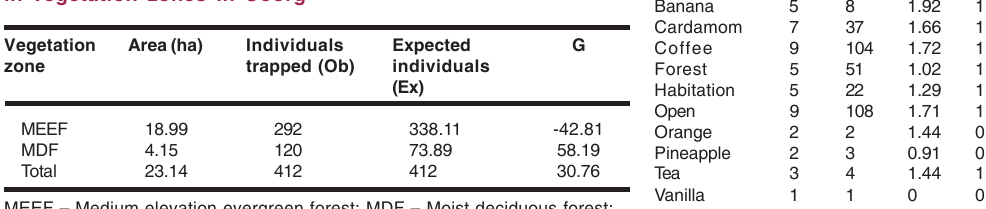
Table 4. Goodness of fit test for small mammal abundance in vegetation zones in Coorg